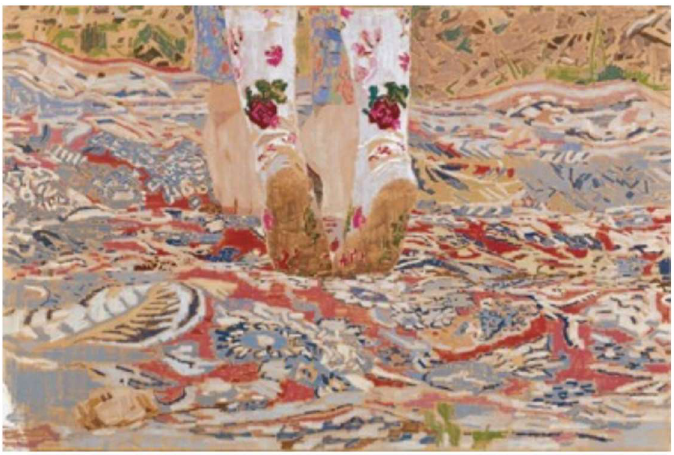
Figure 17. Fama Shana, Lara , 2017, Oil on canvas, 100 × 150, Ann and Dr. Ari Rosenblatt collection, USA.